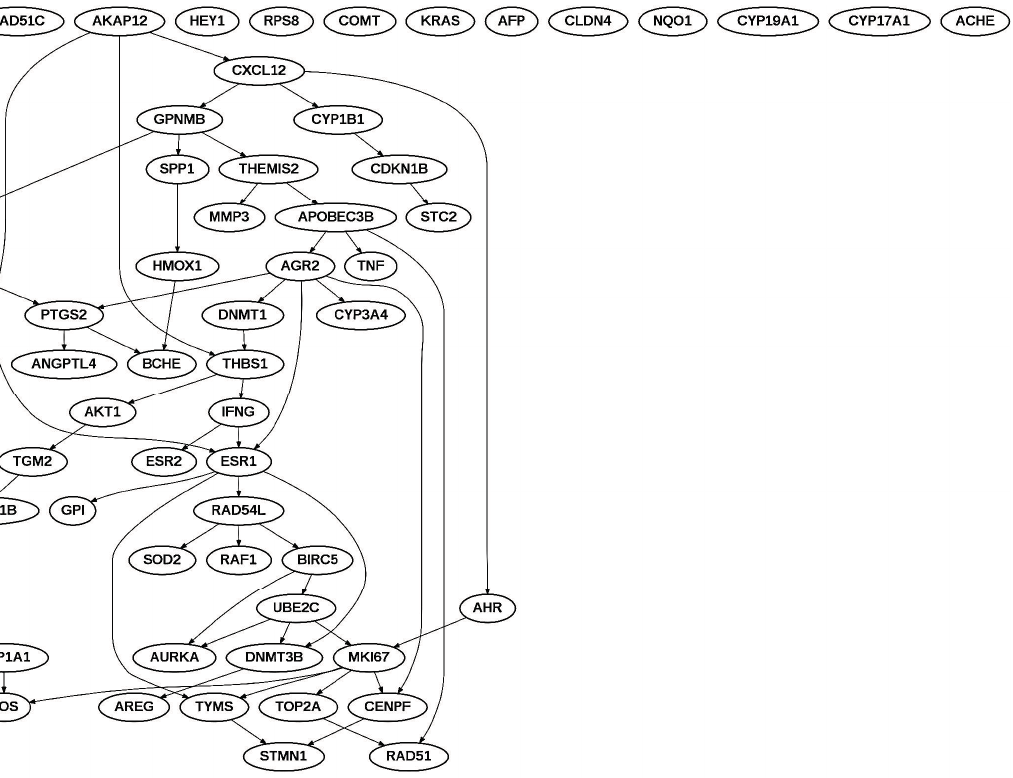
Figure 6. Interaction of common genes between estrogen, PCBs and breast neoplasms— AREG , CYP19A1 , EGFR , ESR2 , FOS , IGF1 , KRAS , NCOA1 , NCOR1 , NR2F6, PGR , and STC2 .